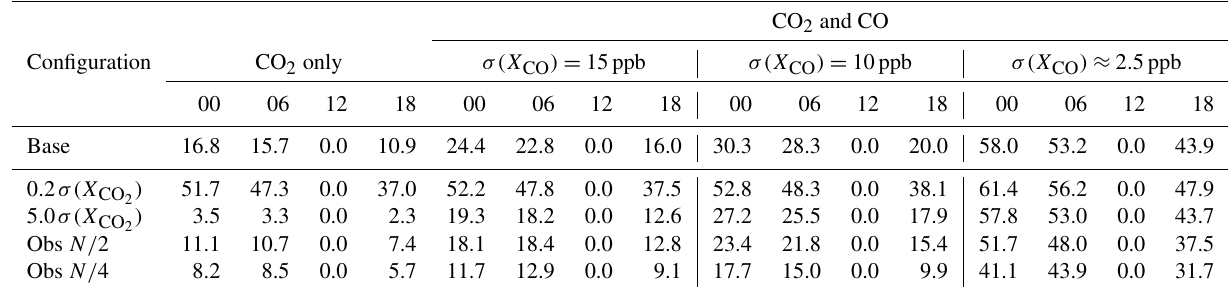
Table 9. Maximum error reduction (in percent). The labels 00, 06, 12 and 18 refer to the UTC time slot.